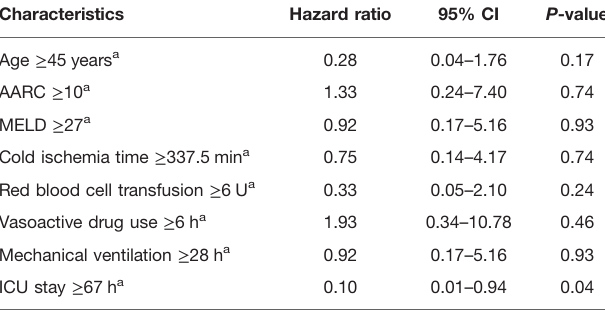
TABLE 3 | Independent predictors of pulmonary infection of ACLF